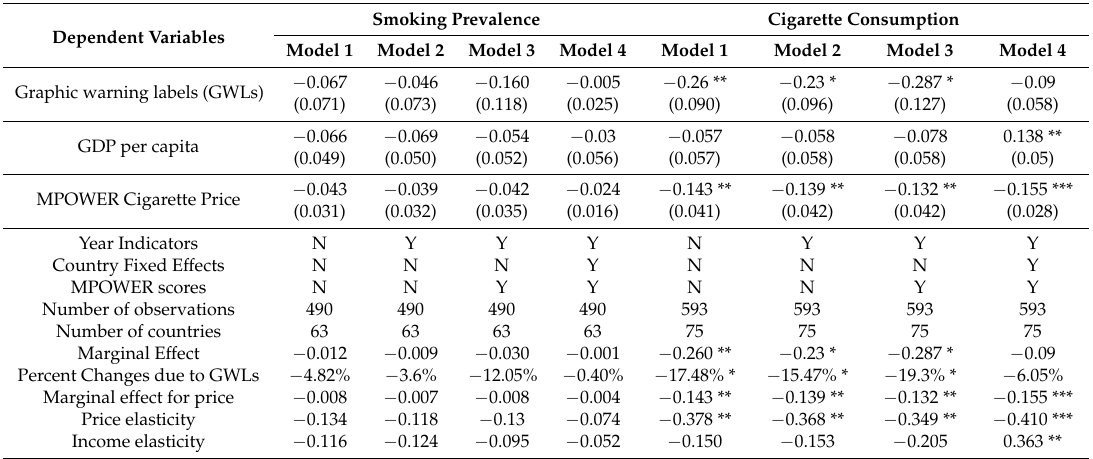
Table 2. The association between graphic warning labels and adult smoking prevalence and cigarette consumption across alternative